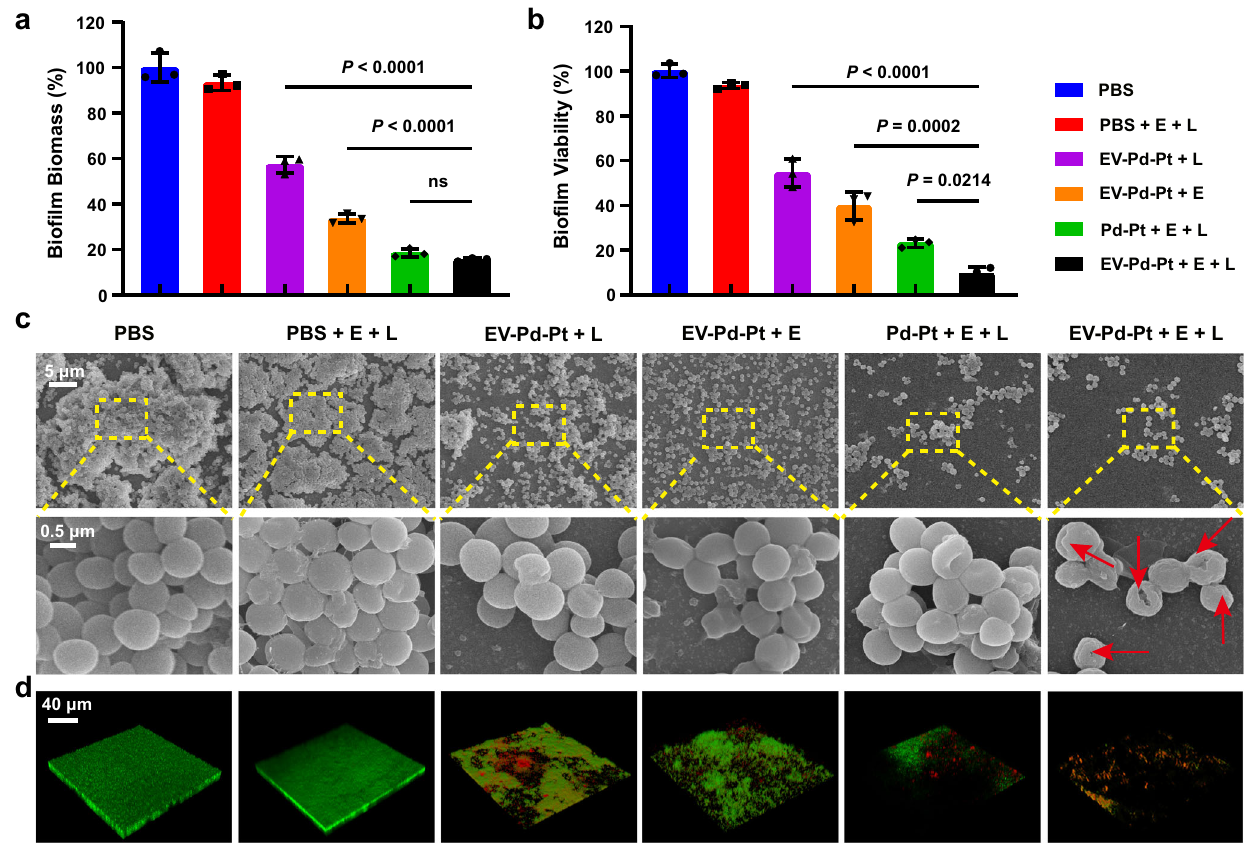
Fig. 6 | Antibio fi lm activity of EV-Pd-Pt nanoparticles. Biomass ( a ) and corre- sponding viability ( b ) of S. aureus bio fi lms after different treatments. Data are presented asmeanvalues±SD( n =3independentsamples).Statisticalsigni fi cance was calculated by one-way analysis of variance (ANOVA). Representative SEM